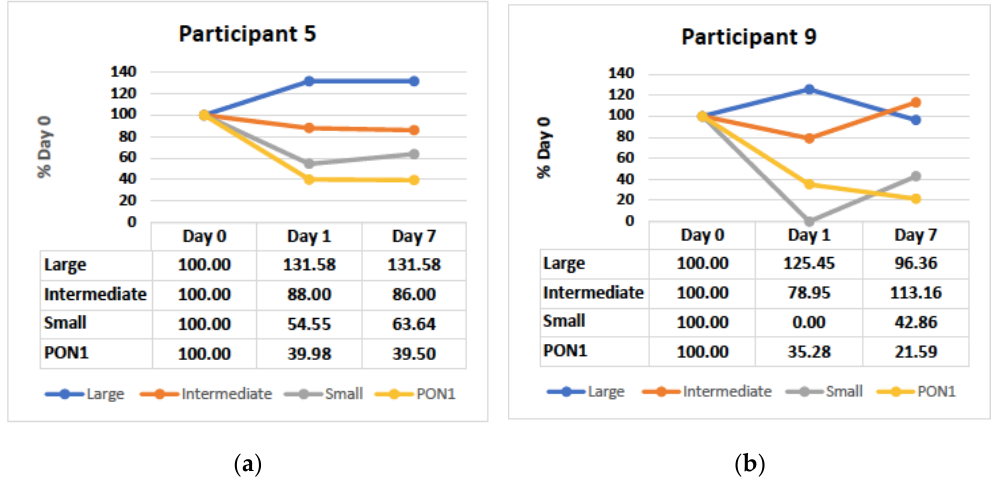
Figure 4. PON1 arylesterase and small, intermediate and large HDL as a percentage of Day 0 for ( a ) participant 5 ( b ) and participant 9.